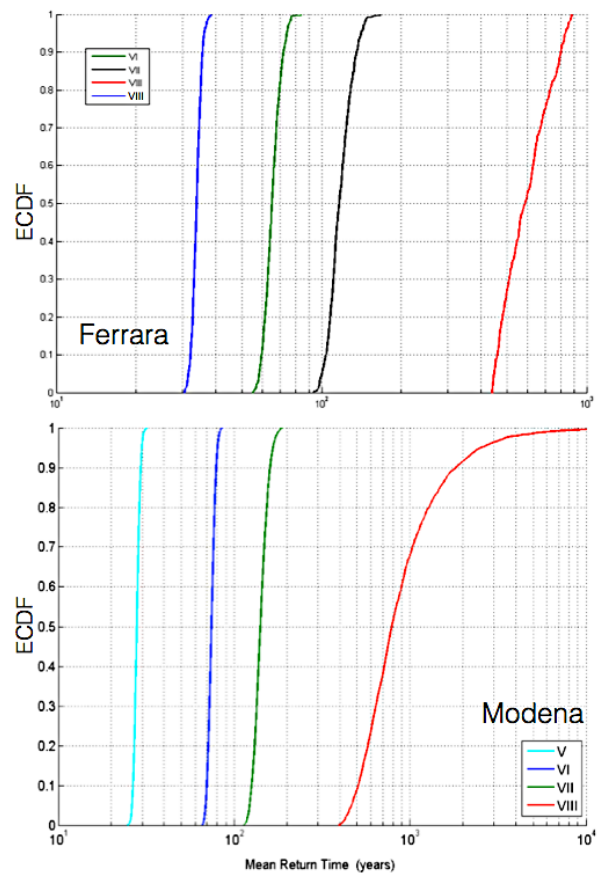
Figure 1. Empirical cumulative distribution functions of the MRT in Ferrara (above) and Modena (below), produced by 5000 simula- tion runs for some of the intensity